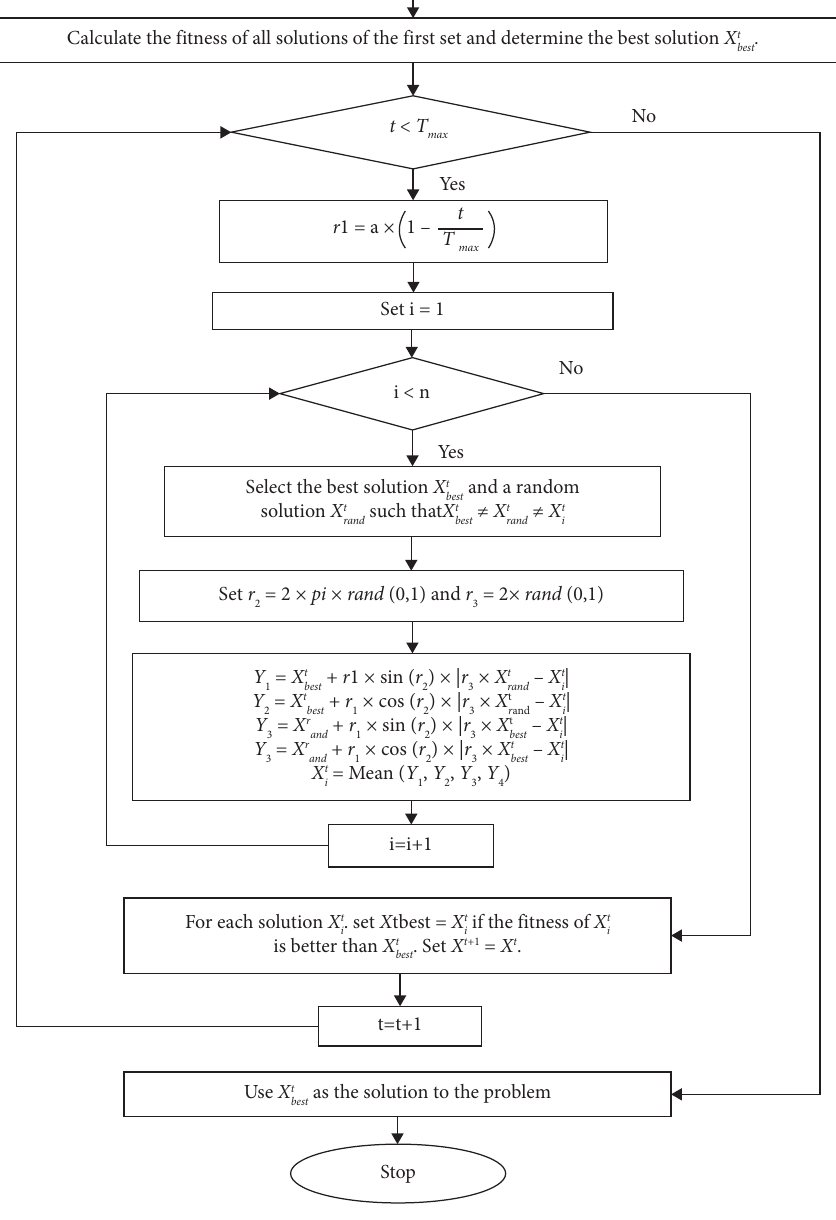
Figure 1: Flowchart for the SSCA